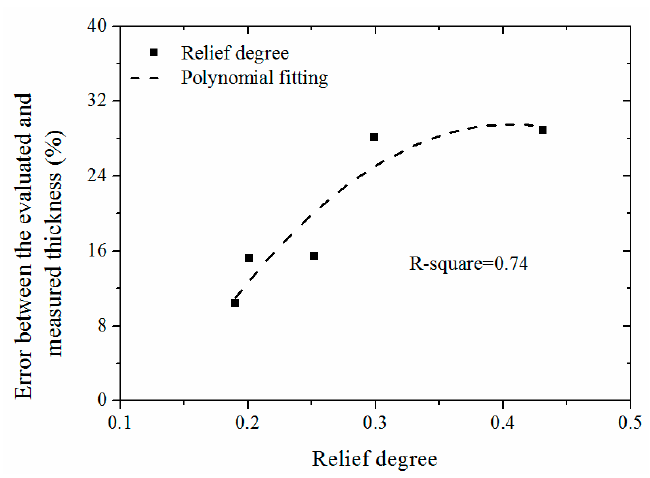
Figure 9. Relationship between the error and the relief degree.